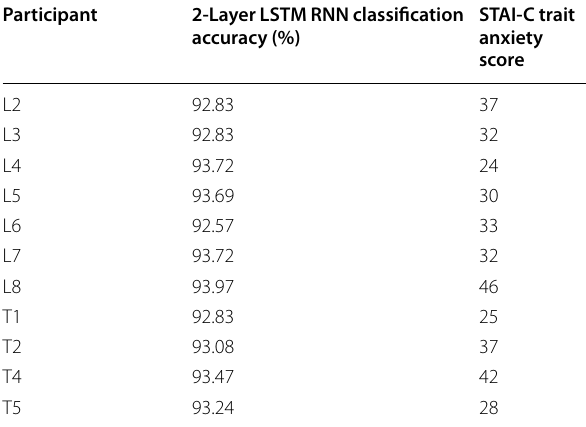
Table 4 2‑Layer LSTM RNN classification accuracy and trait anxiety per participant